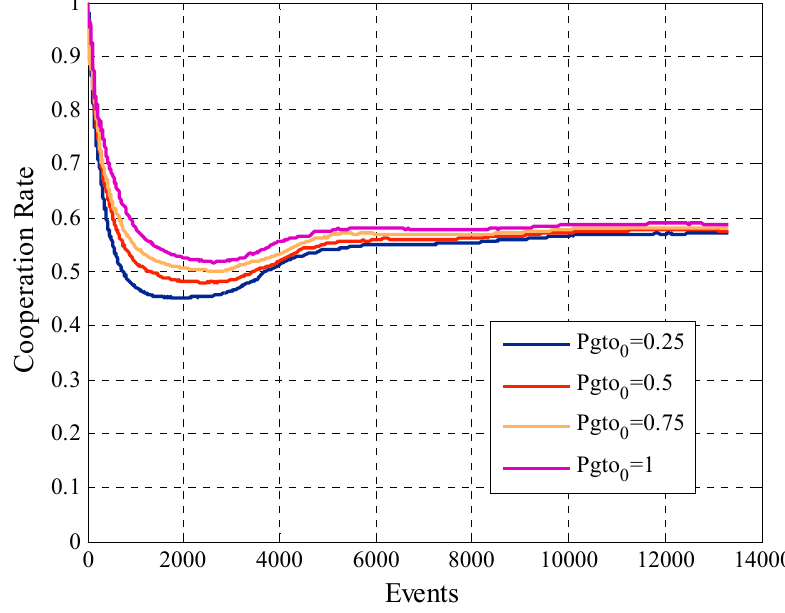
Figure 15. Cooperation rate for configurations with different values of 𝑃𝑔𝑡𝑜 (cid:2868) .